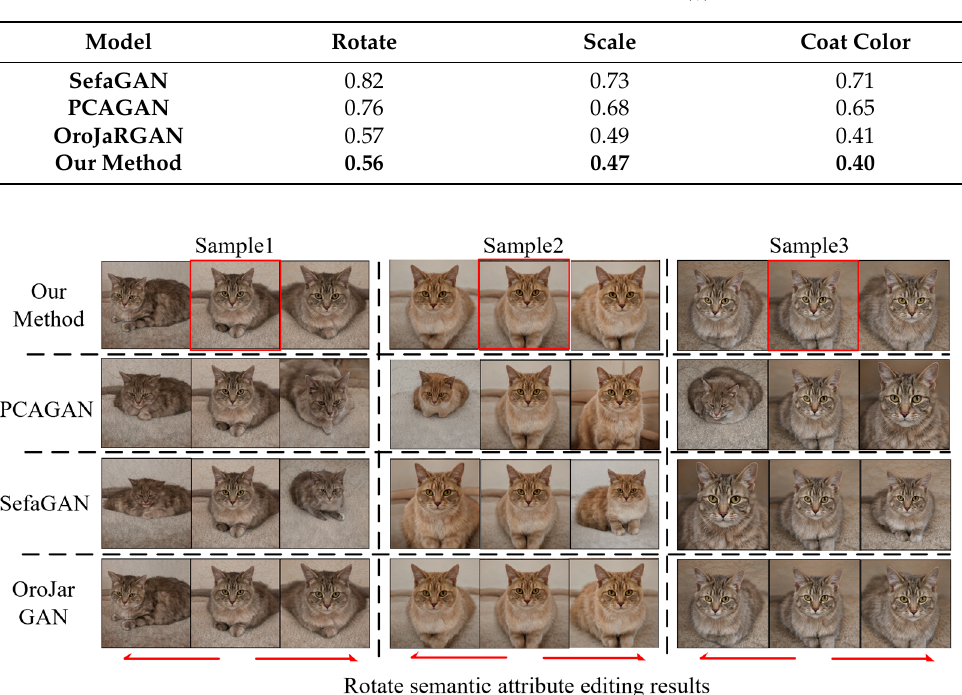
Figure 13. LSUNCat dataset Coat color semantic attribute editing comparison results. To verify the effectiveness of the local Jacobian disentangled method, we compared the performance of the local contrast regularization method with the non-regularization method in local semantic attribute disentanglement, and the PPL score is still used as the evaluation metric. Four representative local semantic attributes, glasses, mouth, hairstyle, and hair color, were selected for the FFHQ dataset, and three local semantic attributes, i.e., head posture, head color, and abdominal color, were selected for the LSUNCat dataset. The results are shown in Tables 4 and 5. Table 4. PPL scores of FFHQ dataset local Jacobi disentangled method attribute directions ( ↓ ). Model